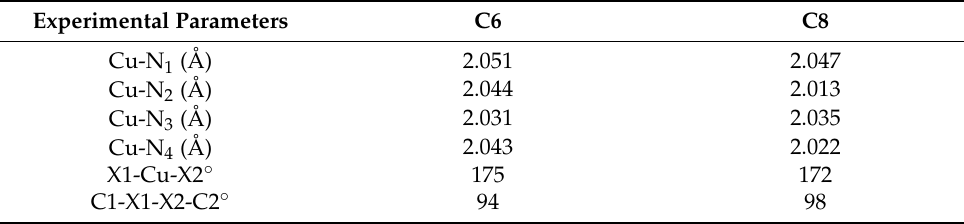
Figure 6. X-ray structures of ( a ) C6 and ( b ) C8 .